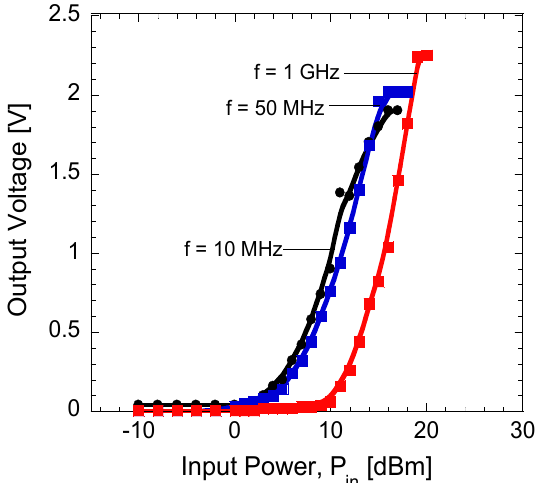
Figure 5. Rectified output voltages as a function of input voltages at frequency of 10 MHz, 50 MHz and 1